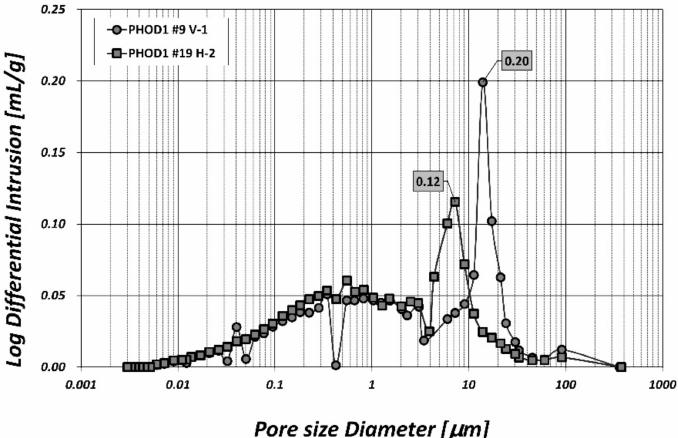
Figure 3. Pore size distribution of samples PHOD-1 #9 V-1 (depth = 739 m) and PHOD-1 #19 H-2 (depth = 779